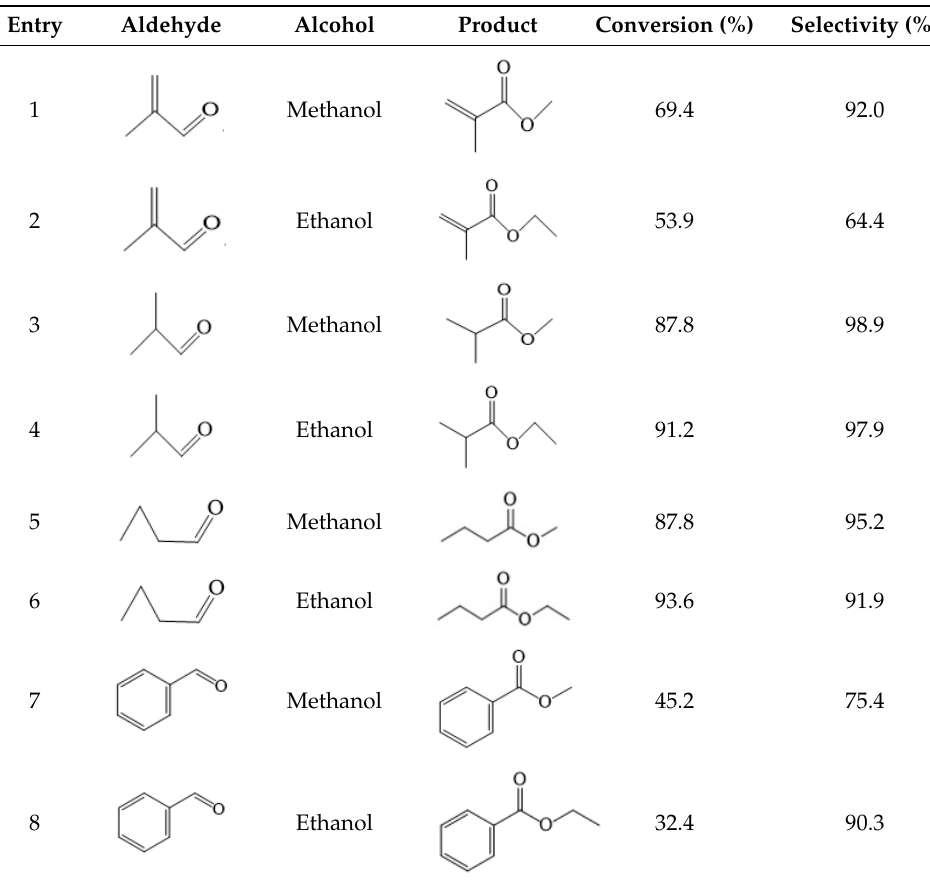
Table 3. Catalytic performances of various aldehydes and alcohols to form the esters by oxidative esterification over the Au 25 /Zn 2 Al-400 catalyst.